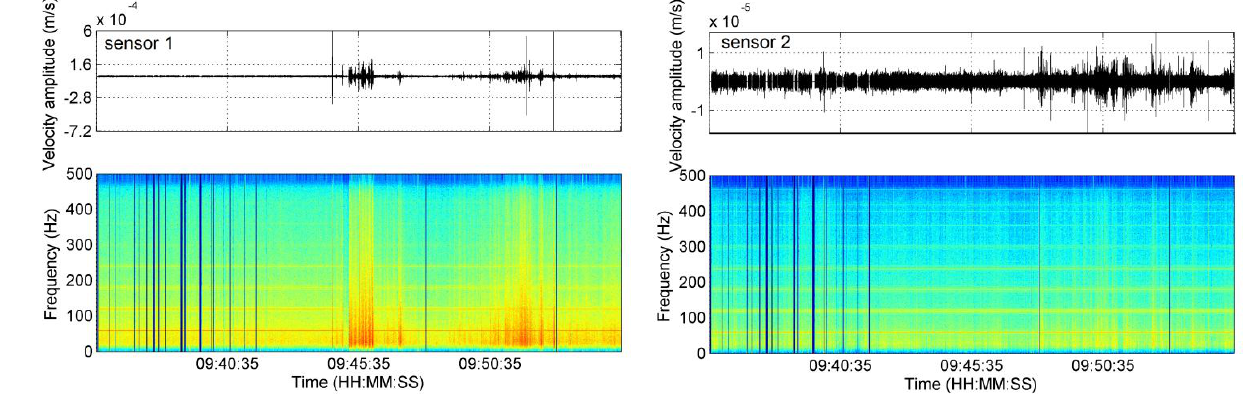
Figure 2. Vertical component waveform recordings and corresponding spectrograms calculated for each geophone framing twenty-minute time-windows around the onset time of the outflow (09:41). The amplitude of each frequency appears color-encoded. g.2